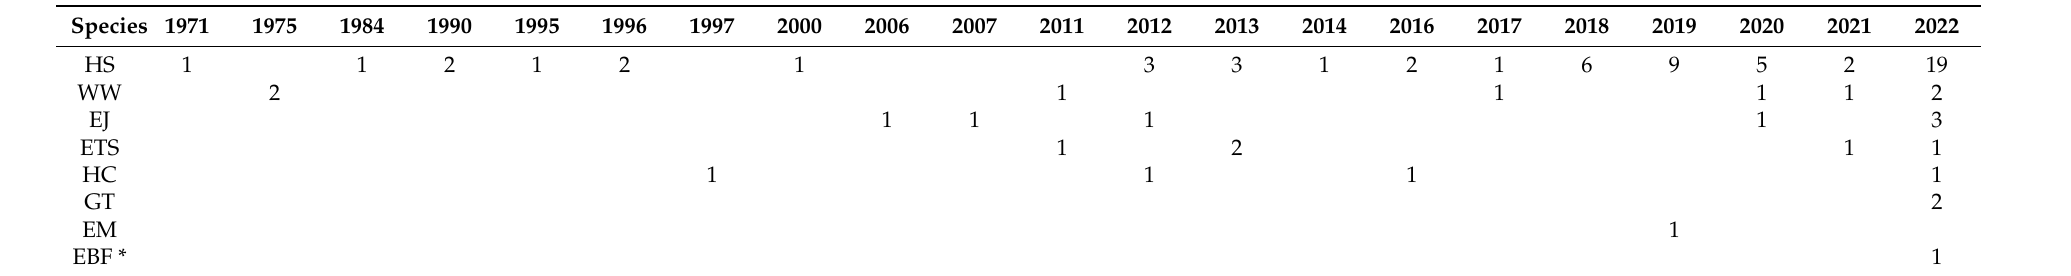
Table 1. Number of foraging observations of different bird species (HS = House Sparrow; WW = White Wagtail; EJ = Eurasian Jackdaw; ETS = Eurasian Tree Sparrow; HC = Hooded Crow; GT = Great Tit; EM = Eurasian Magpie; and EBW = Eurasian Bullfinch) on the front panels of cars in Finland in 1971–2022. Note, some reported observations lack the observation year; therefore, these observations are not included in this table. * picking insects from the windscreen